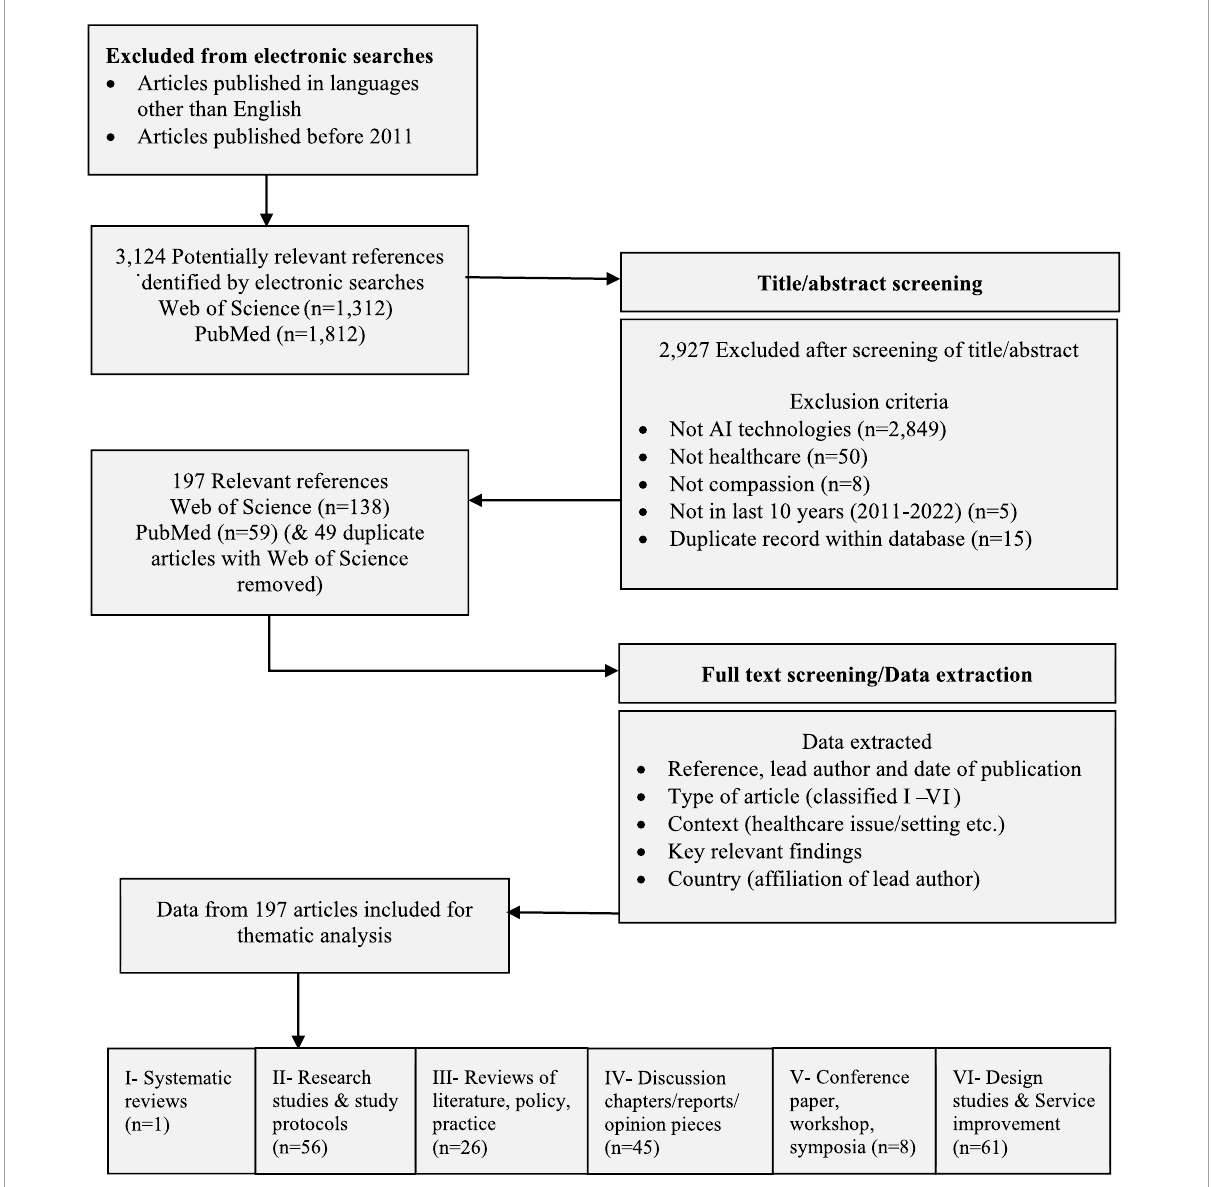
FIGURE1 Inclusion flow